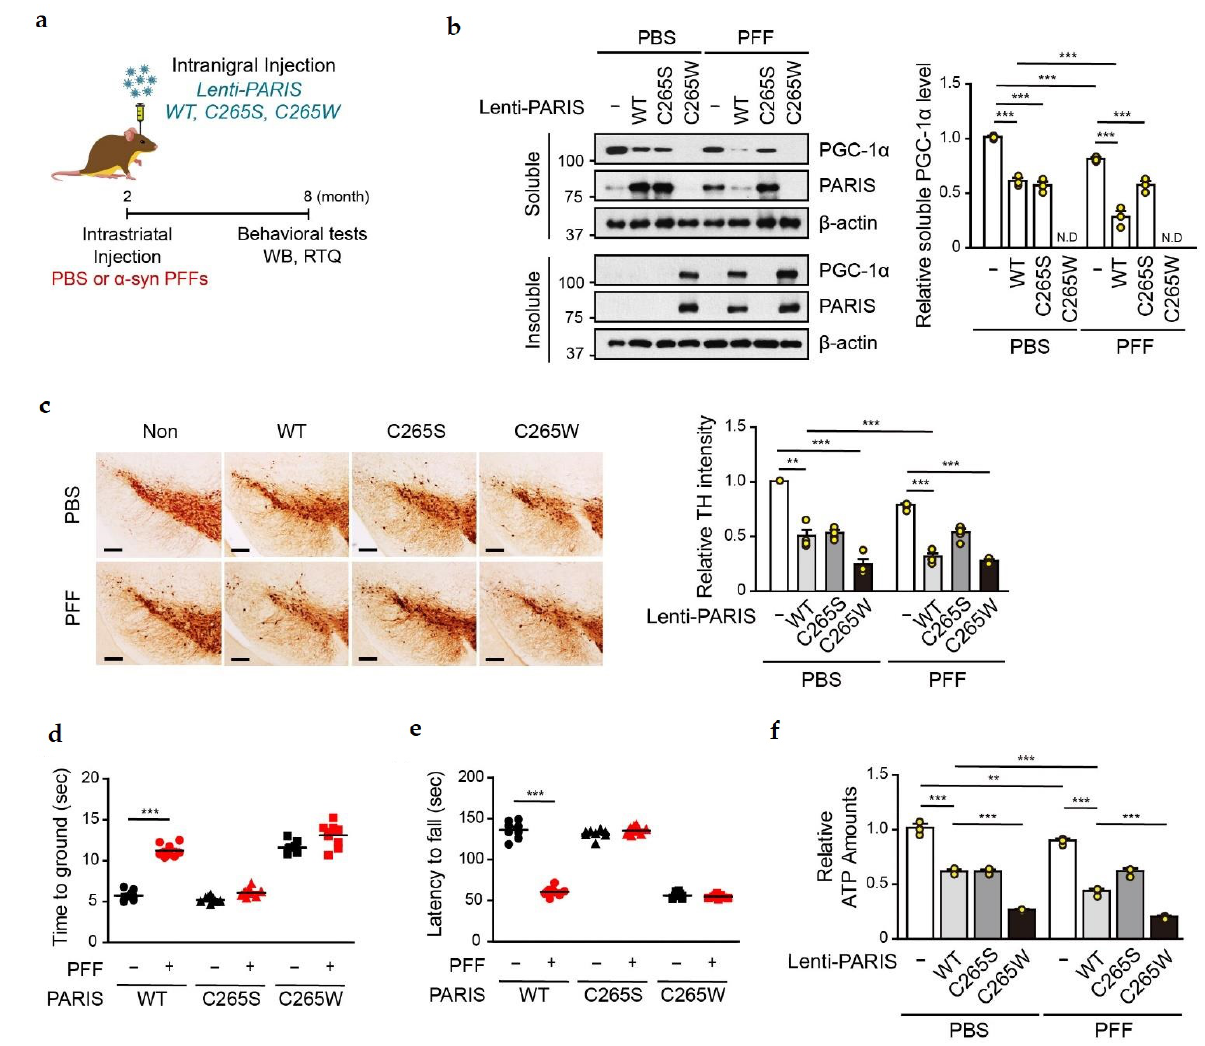
Figure 6. Loss of functional PGC-1 α due to α -syn PFFs is SNO-PARIS-dependent. ( a ) Study timeline for intrastriatal α -syn PFFs injection and intranigral injection of lentiviruses (pLenti-GFP, pLenti- PARIS WT, pLenti-PARIS C265S, and pLenti-PARIS C265W). Biochemical and behavioral testing was performed as indicated in the timeline, and all mice were sacrificed after behavioral experiments. ( b ) PARIS and PGC-1 α levels in RIPA-soluble and RIPA-insoluble fractions of the SN region of α -syn PFFs/lentiviruses injected mice. Right panel—relative PGC-1 α level in the soluble fraction normalized to β -actin level. n = 3. Two-way ANOVA followed by Bonferroni’s post-test, *** p < 0.001. N.D, not detected. ( c ) Representative TH staining of the midbrain sections from the SN region of α -syn PFFs/lentiviruses-injected mice. Scale bar = 200 µ m. Right panel—relative TH intensity was measured by using the ImageJ software. n = 4. Two-way ANOVA, followed by Bonferroni’s post-test, ** p < 0.01, *** p < 0.001. Pole test ( d ) and rotarod test ( e ) of α -syn PFFs/lentiviruses-injected mice *** p < 0.001. ( f ) Relative ATP levels in the SN region of α -syn PFFs/lentiviruses-injected mice ** p < 0.01, *** p <